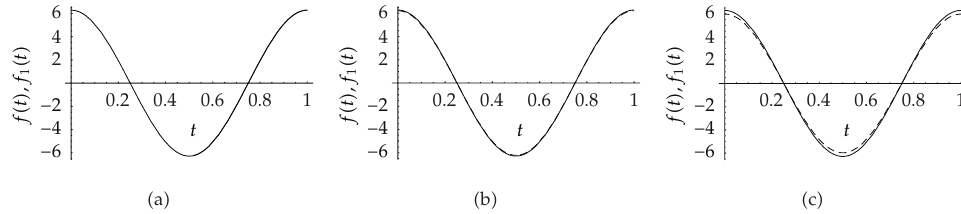
Figure 3: Figures of f (cid:5) t (cid:6) and f 1 (cid:5) t (cid:6) with noise σ (cid:4) 0 . 1%, 1%, 5%, respectively, for Example 4.2 (cid:5) the real line is f (cid:5) t (cid:6) and the dashed line is f 1 (cid:5) t (cid:6)(cid:6)